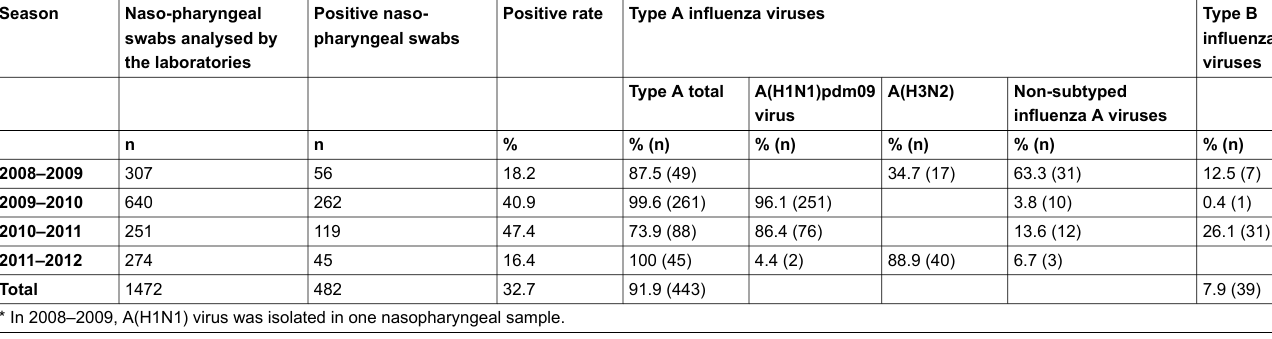
Table 2: Description of the influenza viruses isolated by the MISS network – influenza seasons 2008–2009 to 2011–2012.